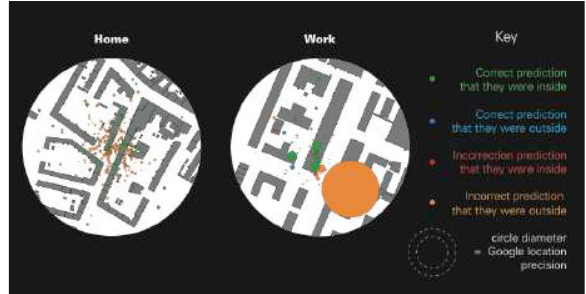
Figure 11: Dots show whether the GPS collection via Google SDK using Lillebrot correctly predicted whether a user was inside or outside. In this ground truth exercise, participants manually logged when